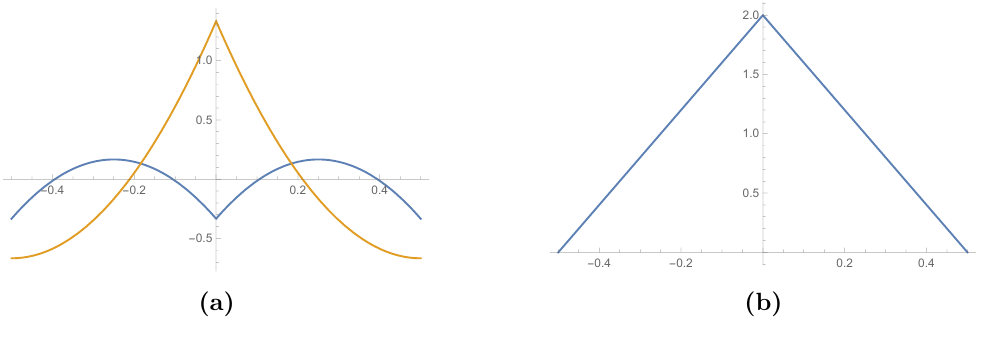
Figure 3. Warp factor H (cid:2) l s given in (3.18) for one O 8 at (cid:27) = 0, one at (cid:27) = (cid:6) 1 g s L at (cid:27) = 0. The separate source contributions to H are shown in (cid:12)gure 3a: the bottom blue curve is that of the O 8 , while the top orange curve is that of the D 8 . The overall warp factor (3.18), including the constant, appears in (cid:12)gure